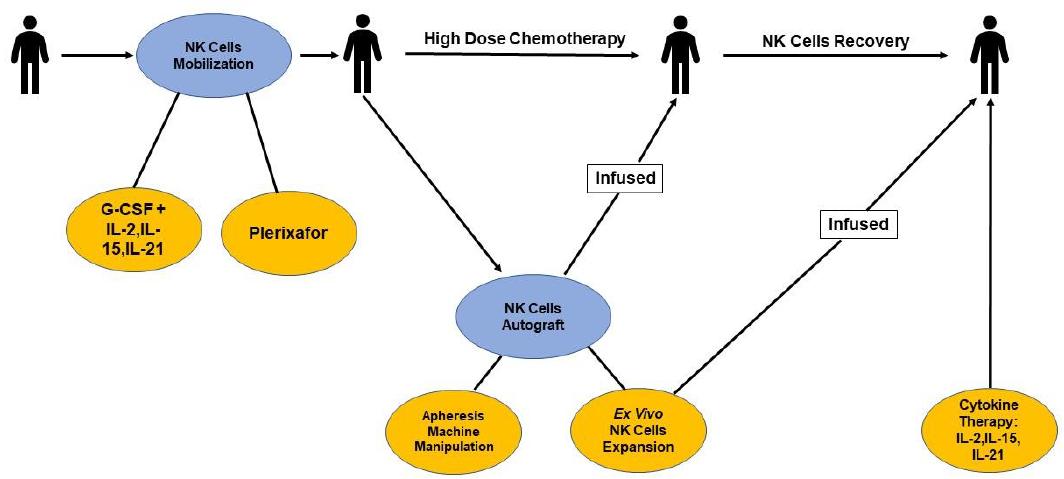
Figure 1. Schematic representation of natural killer (NK) cell graft engineering and recovery in autologous peripheral blood hematopoietic stem cell transplantation (APBHSCT). NK cell mobiliza- tion strategies include the use of Plerixafor and cytokines (i.e., IL-2, IL-15, and IL-21) to enhance the mobilization of NK cells in the peripheral blood for harvesting. NK cell autograft strategies include the manipulation of the apheresis machine to harvest high numbers of lymphocytes/NK cells and to harvest NK cells from the autograft for ex vivo expansion. NK cell engraftment/recovery post-APBHSCT includes ex vivo NK cell expansion infusions and the use of cytokines (i.e., IL-2, IL-15, and